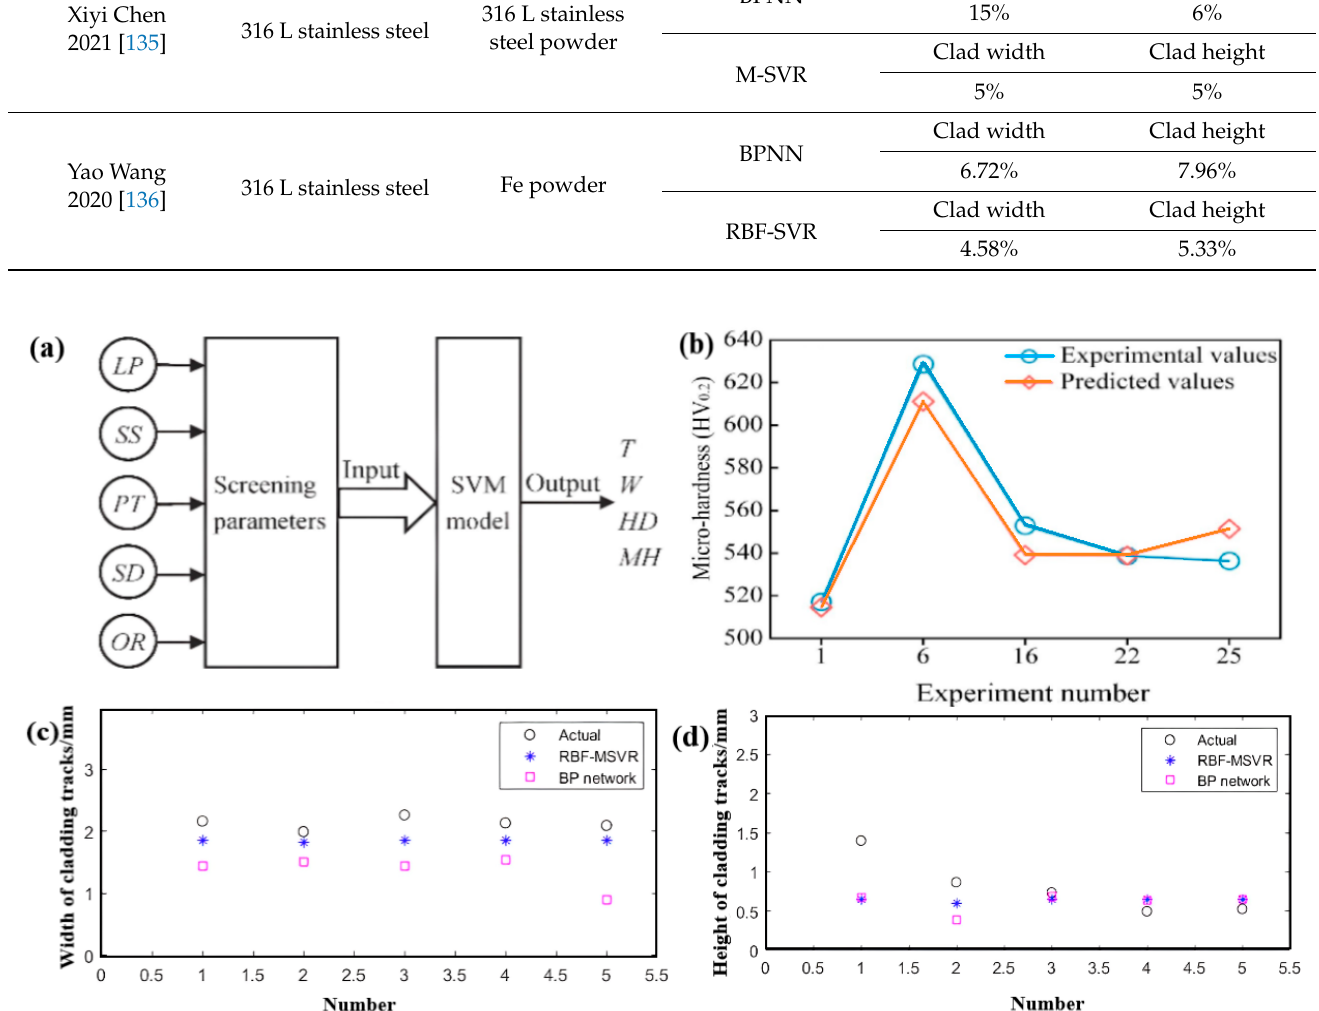
Figure 8. A prediction model framework for support vector machine, comparison of predicted and experimental values of SVR, and comparison of the predicted values of SVR and BPNN. ( a ) The prediction model framework of the support vector machine. Reprinted with permission from Ref. [134]. 2019, Elsevier. ( b ) Predicted results for microhardness and experimental values. Reprinted with permission from Ref. [134]. 2019, Elsevier. ( c ) Comparison of the predicted values of the clad width of SVR and BPNN [135]. ( d ) Comparison of the predicted values of the clad height of SVR and BPNN [135].